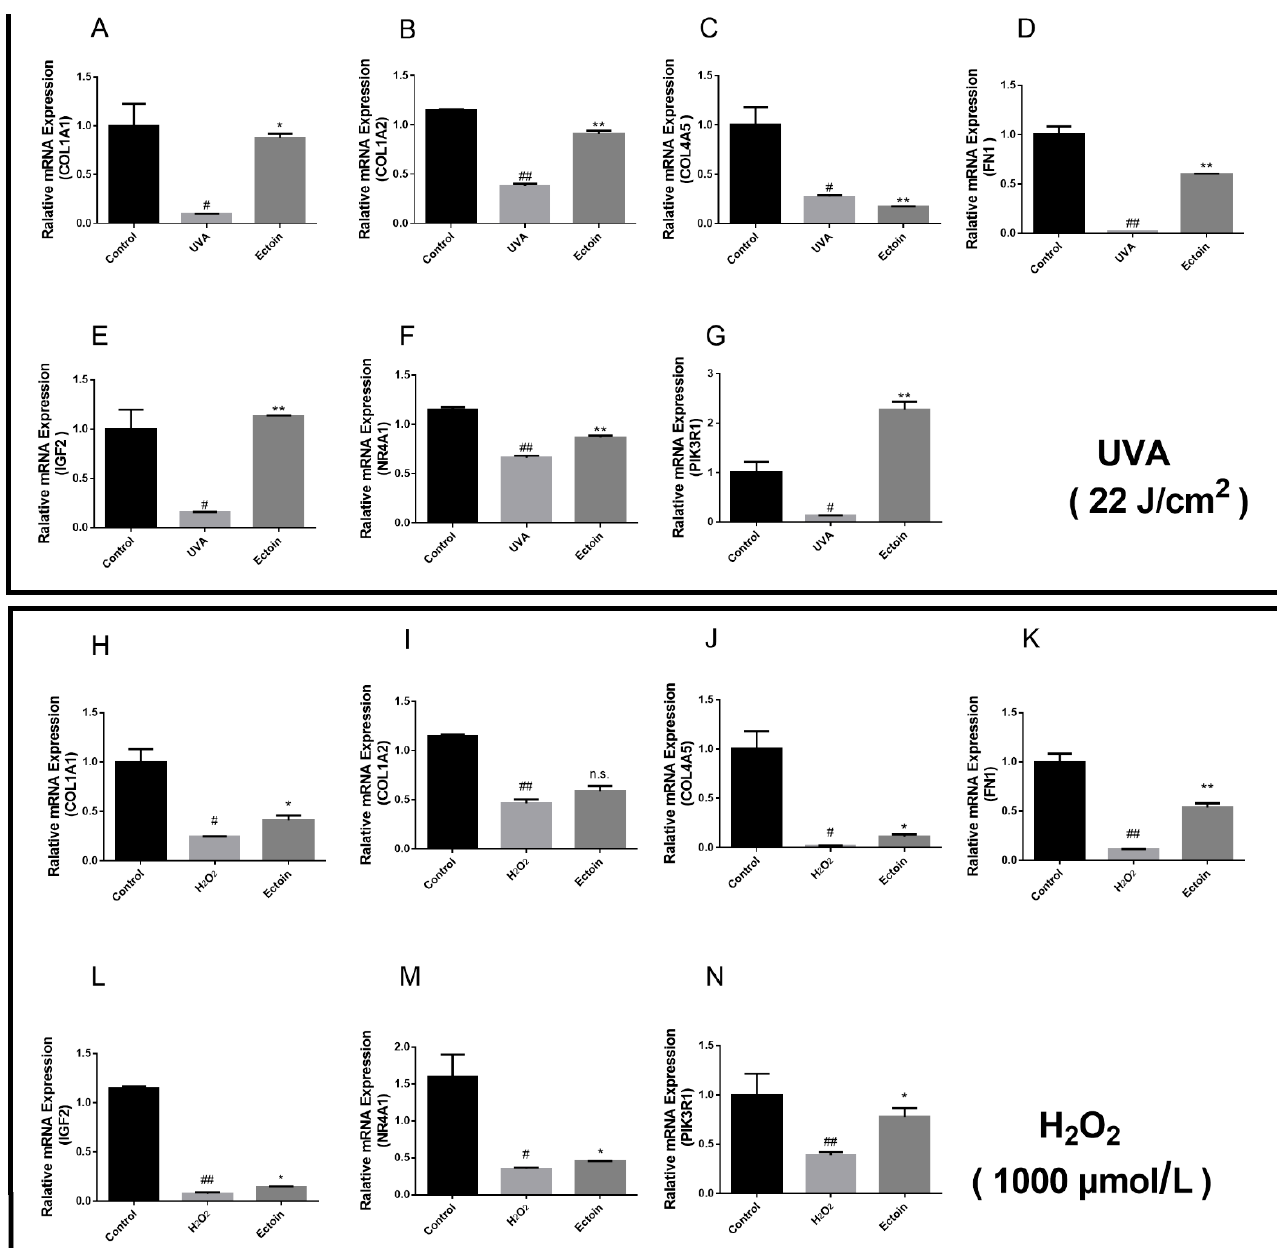
Figure 5. The relative gene expression changes after the repair of Ectoin on UVA and H 2 O 2 injury. Genes, COL1A1 ( A , H ), COL1A2 ( B , I ), COL4A5 ( C , J ), FN1 ( D , K ), IGF2 ( E , L ), NR4A1 ( F , M ), and PIK3R1 ( G , N ) were measured. The model in ( A – G ) was established by UVA (22 J/cm 2 ), and the model in ( H – N ) was established by H 2 O 2 (1000 μ mol·L − 1 ). Statistical significance was determined by ANOVA test. (## p < 0.01, and # p < 0.05, compared with the Control. * p < 0.05, and ** p < 0.01,